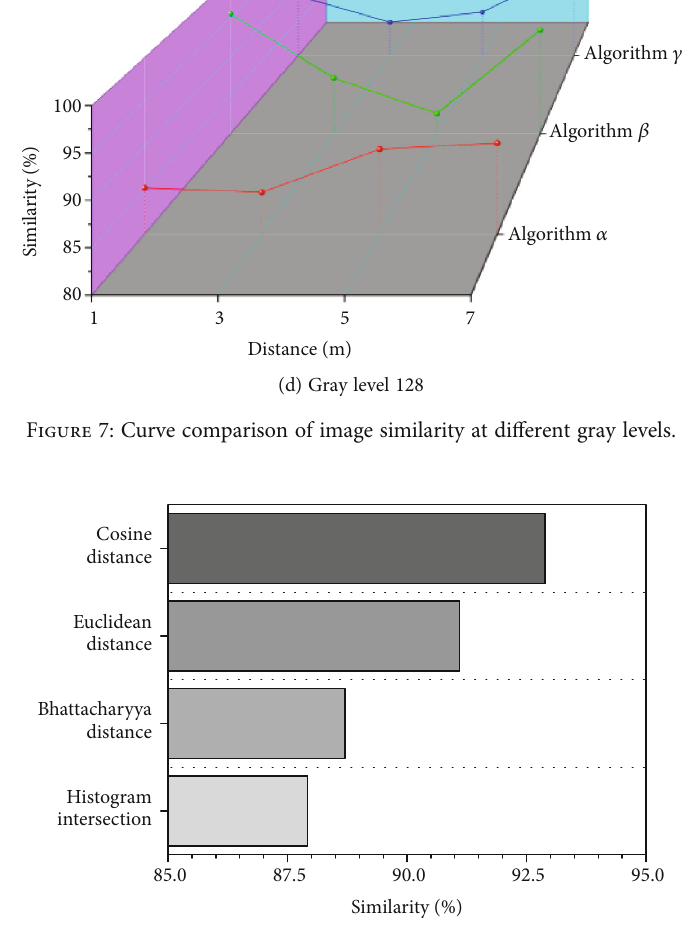
Figure 8: Comparison between original image and enhanced